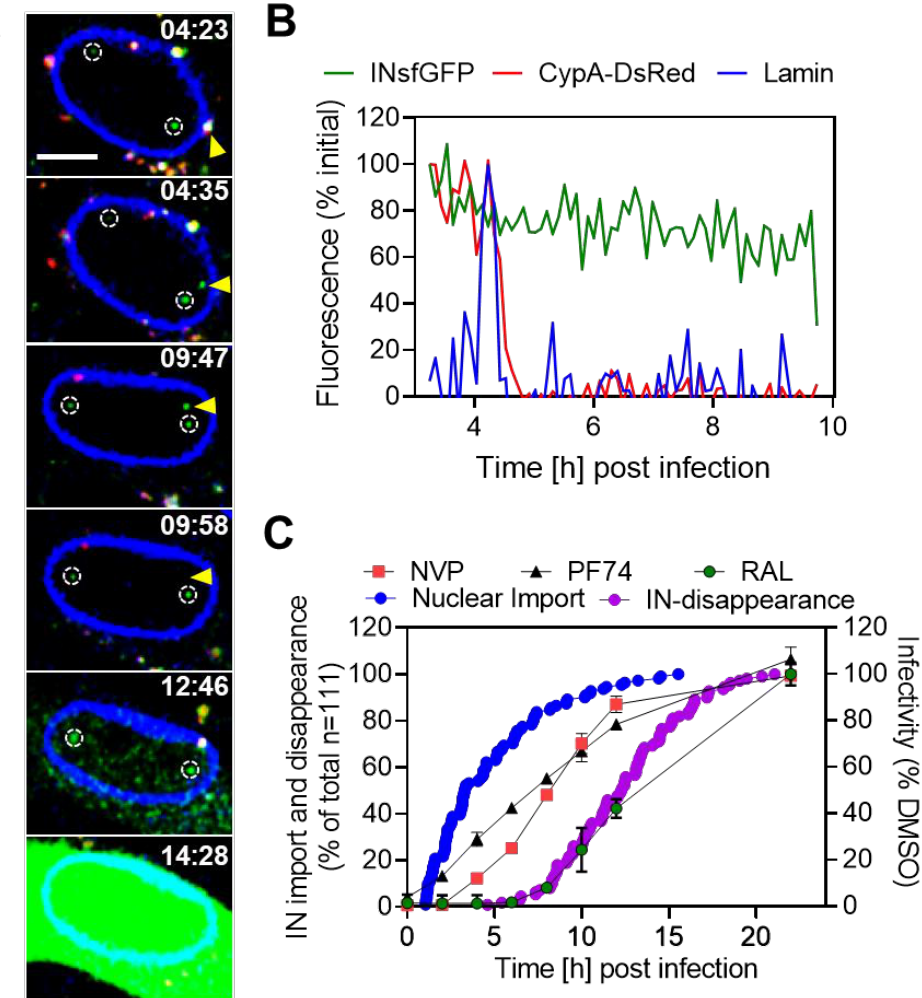
Figure 1. Time course of HIV-1 uncoating, nuclear import, reverse transcription, and integration in TZM-bl cells. HIV-1 uncoating, nuclear import, and integration in the context of infection in TZM-bl cells were visualized by live-cell imaging. ( A ) Images and ( B ) fluorescence intensity traces of single HIV-1 integrase (IN) complex (green) marked by arrow in ( A ) entering the nucleus of a TZM-bl cell after losing cyclophilin A-DsRed (CDR)/capsid assembly (CA) signal (red) at the nuclear envelope labeled by EBFP2-Lamin (blue). Inside the nucleus, the IN-superfolder GFP (INsfGFP) complex traffics for several hours prior to disappearing (a correlate of integration, marked by an arrowhead) at 12 h 20 min, which is followed by expression of HIV-encoded eGFP reporter starting at 14 h 15 min. The two additional nuclear INsfGFP puncta (marked by dashed lines) that do not disappear in the nucleus likely represent nonproductive nuclear entry events. Scale bar in ( A ) is 5 µm. ( C ) Comparison of the time courses of HIV-1 nuclear import, completion of viral cDNA (vDNA) synthesis, and integration. The kinetics of nuclear import (blue circles) and INsfGFP disappearance (green circles) in TZM-bl cells were obtained by live-cell imaging, as shown in ( A , B ). The kinetics of completion of reverse transcription and integration were determined in parallel experiments by adding nevirapine (NVP, 10 µM), PF74 (2 µM), and raltegravir (RAL, 10 µM) at indicated time points after infection. The resulting infection (luciferase signal) is plotted on the right axis. Data in ( C ) are represented as cumulative of n = 111 nuclear import and disappearance events obtained from live-cell experiments and means and SEM for drug addition experiments are from 3 independent experiments.